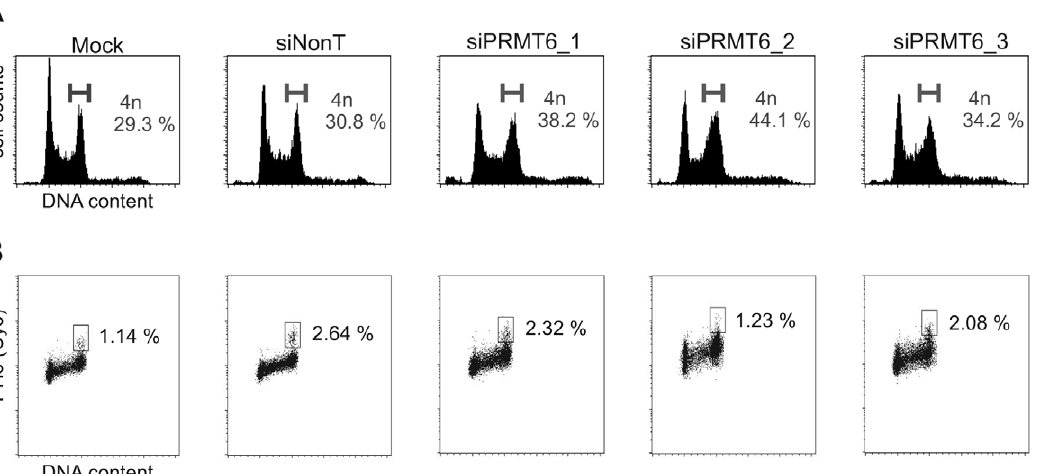
Figure 4. Knockdown of PRMT6 results in an accumulation of cells in G2. (A) U2OS cells were transfected with the indicated siRNAs and fixed 72 h later. For DNA content analysis, cells were stained with propidium iodide and analyzed by flow cytometry. Percentage of cells with a 4n DNA content is indicated. This is a representative example of three biological replicates. (B) Same as in A, this time cells were double stained using propidium iodide and Phospho-H3S10 antibody. Percentage of mitotic cells is indicated.